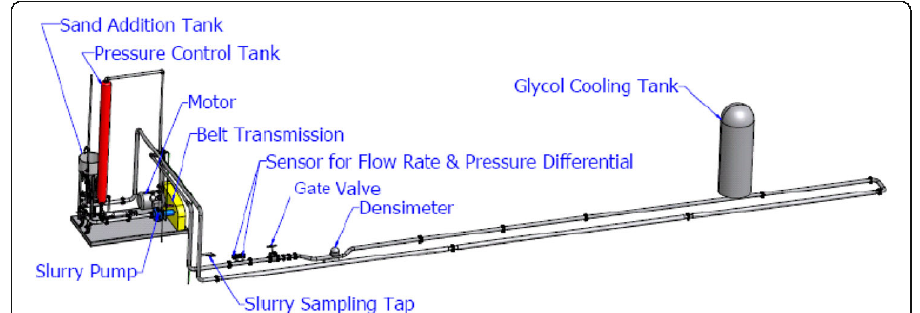
Fig. 10 Schematic diagram of slurry pump fault diagnosis test